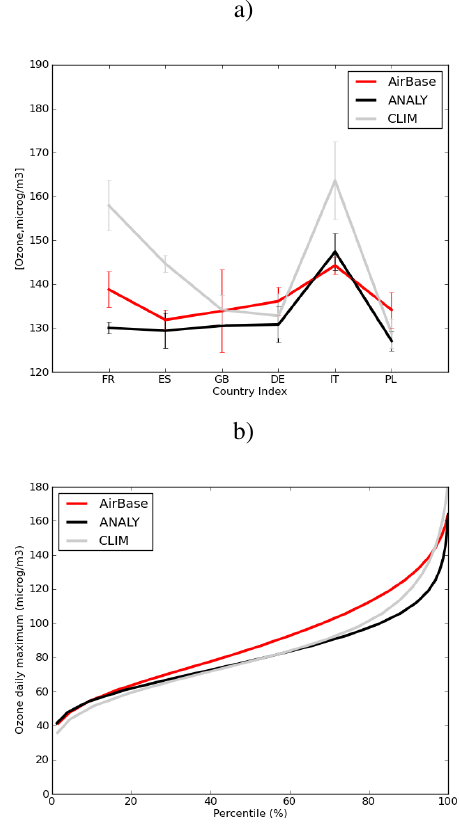
Fig. 12. (a) Summertime average ozone concentrations (over the stations available) above the threshold of 120 µ g m − 3 over 6 European countries. FR is France, ES is Spain, DE is germany, GB is England, IT is Italy, PL is Poland. The standard deviation measuring the inter-annual variability is represented by the vertical bars. (b) Distribution of daily O 3 maximum percentiles for AirBase measurements (red) and MOCAGE simulations (ANALY in black, CLIM in gray).